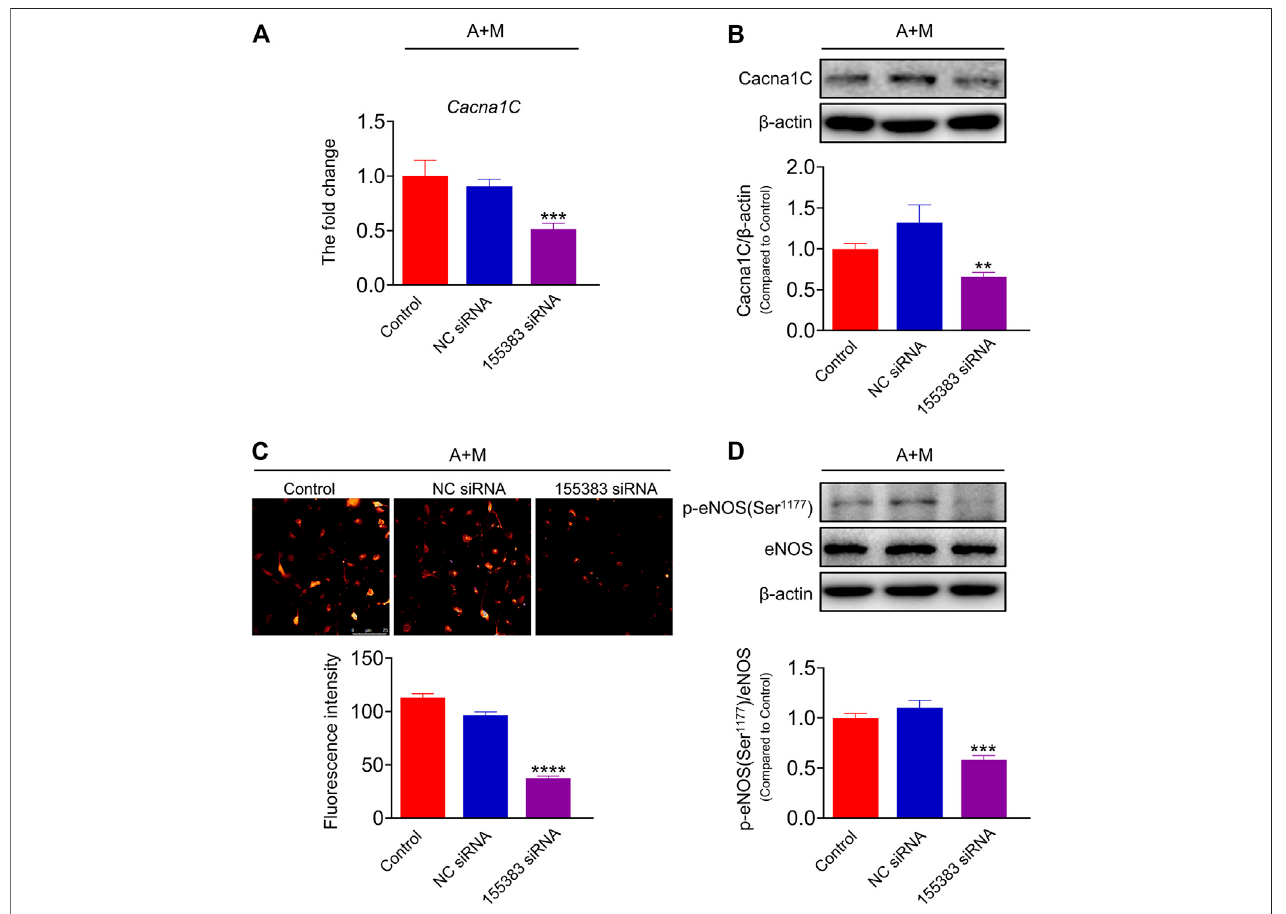
FIGURE 7 | The effects of lncRNA ENSMUST00000155383 silence. Small interfering RNA (siRNA) of lncRNA ENSMUST00000155383 reduced Cacna1c mRNA level (A) and protein expression (B) in the aortic endothelial cells from hypertensive mice. Silencing lncRNA ENSMUST00000155383 resulted in the reduction of Ca 2+ level (C) andeNOS phosphorylation ( D )intheMAECs inhypertension. ** p < 0.01, *** p < 0.001, **** p < 0.0001 vs NC siRNA.Dataareexpressed asmean ± SEM.( n (cid:1) 4 – 6 forWesternblot; n (cid:1) 80individualcellsforthemeasurementofCa 2+ level,scalebar (cid:1) 75 μ m).155383,lncRNAENSMUST00000155383; A+M, Ang Ⅱ +MK-626.